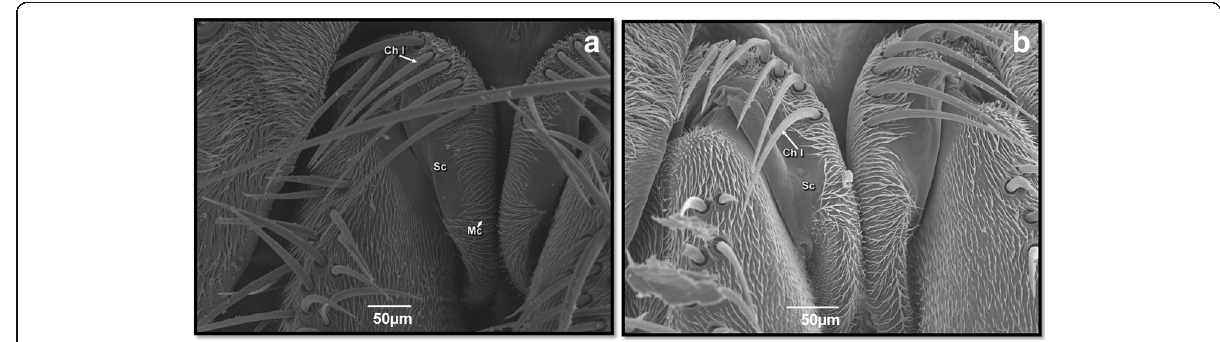
Fig. 2 Scanning electron micrographs showing the cuticular surface of scape in both genders of Mesembrinella bellardiana : a female (× 270), b male (× 330). Sc = scape; ChI = chaetic sensilla; Mc =